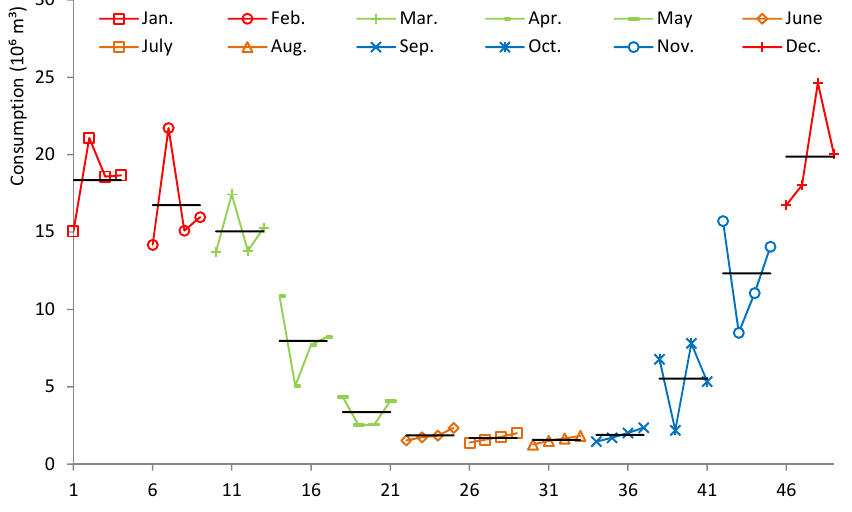
Figure 2. Monthly consumption subplot by years.